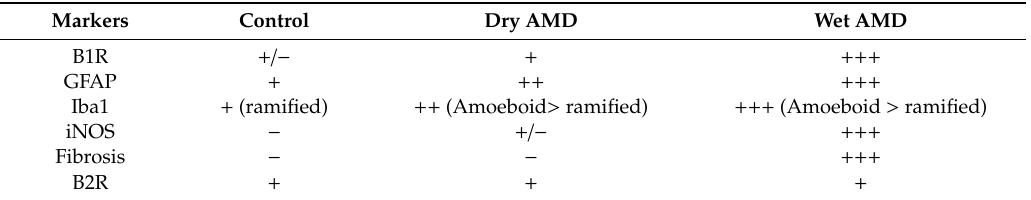
Table3. Summaryofthedi ff erencesinproteinexpressionbetweenthecontrol, dryandwetAMDretinae. Markers